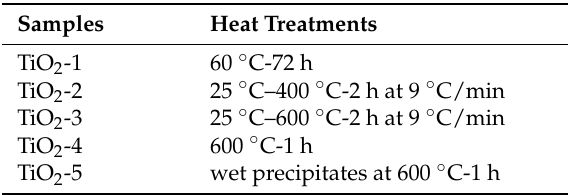
Table 1. Different heat treatments of the TiO 2 nanoparticles.